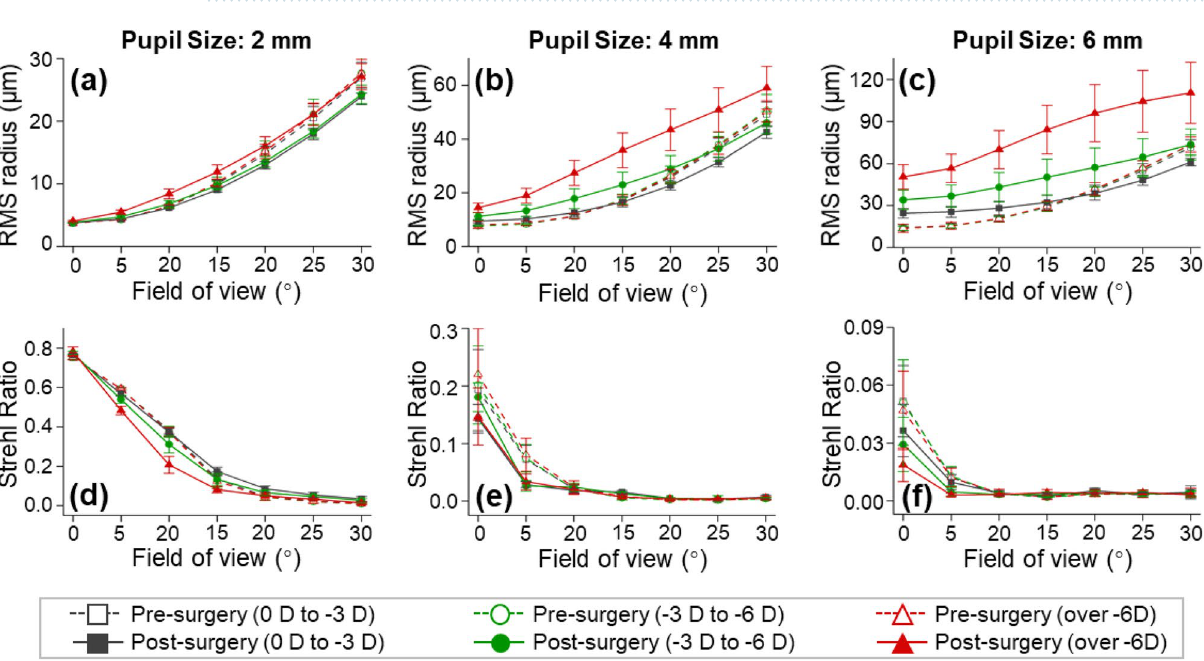
Figure 4. Spot size ( a – c ) and polychromatic PSF Strehl ratio ( d – f ) analysis (mean ± SD) at retina before and after femto-LASIK. The analysis was performed across the field of view (0°–30°), at 2-mm, 4-mm, and 6-mm pupil sizes, and for different initial myopic groups including mild myopia (0 to − 3 D), medium myopia (− 3 to − 6 D), and high myopia (over − 6 D),